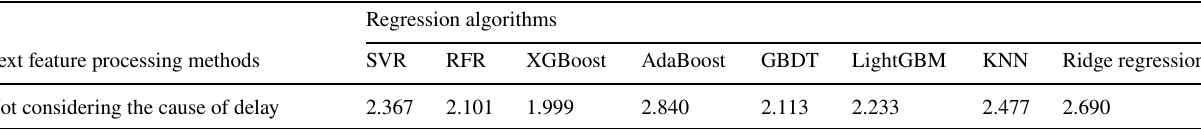
Table 9 MAE of each regression algorithm without considering the cause of delay Regression algorithms